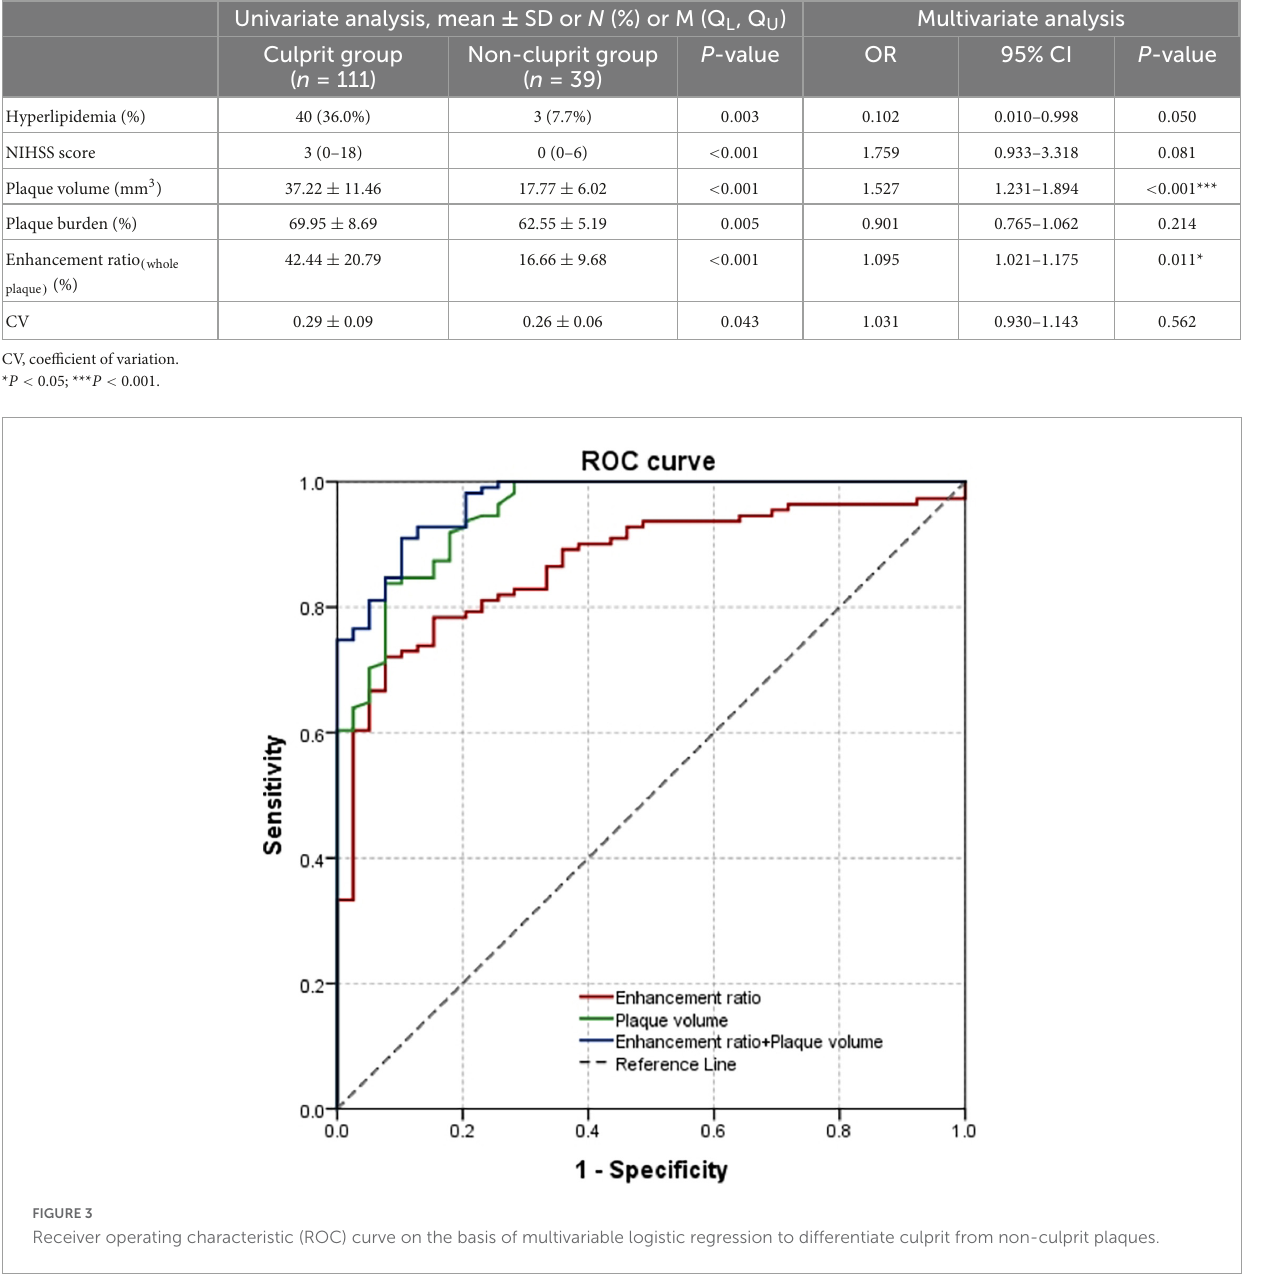
poor homogeneity may have more smaller volume, in which the role of the plaque homogeneity could be